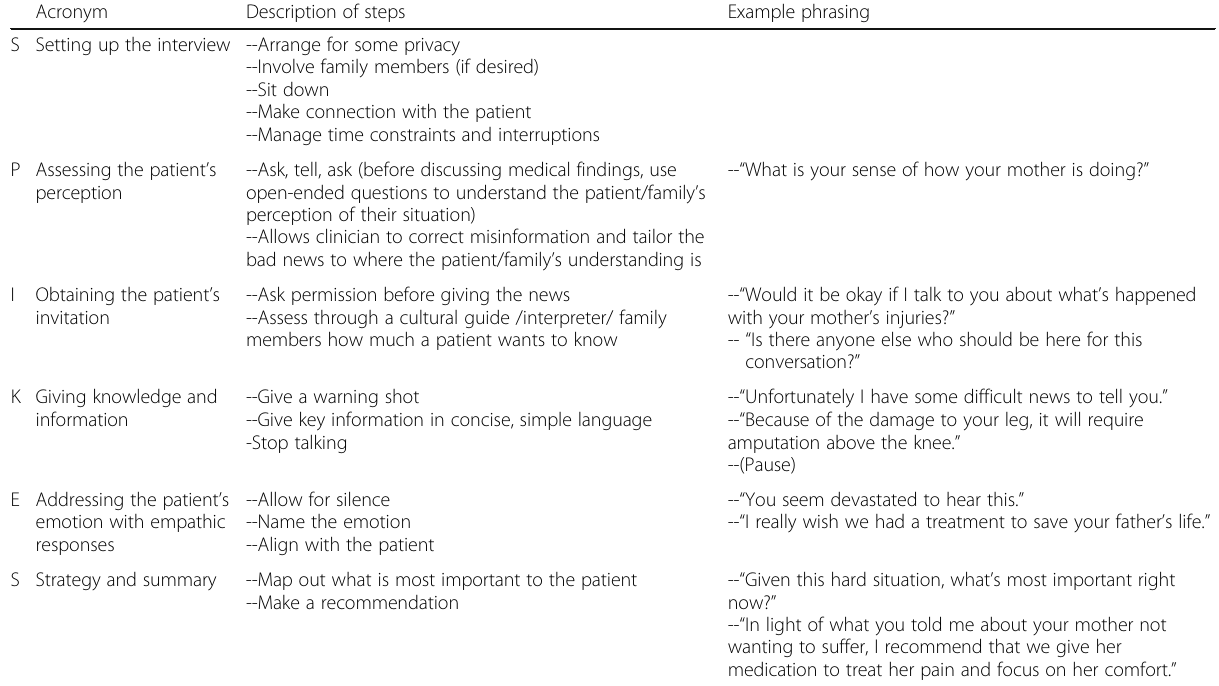
Table 4 SPIKES tool in the disaster setting